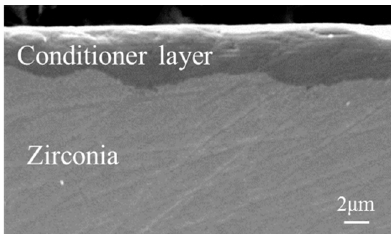
Figure 4. Cross-sectional scanning electron microscopy (SEM) micrograph of a conditioner-coated specimen (5000× magnification).